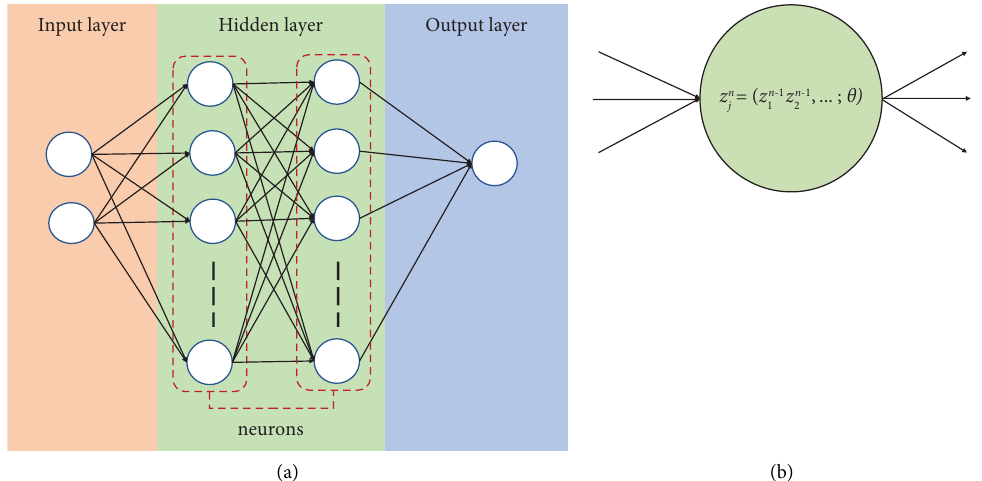
Figure 1: Schematic diagrams of a deep neural network (a) and a neuron (b)